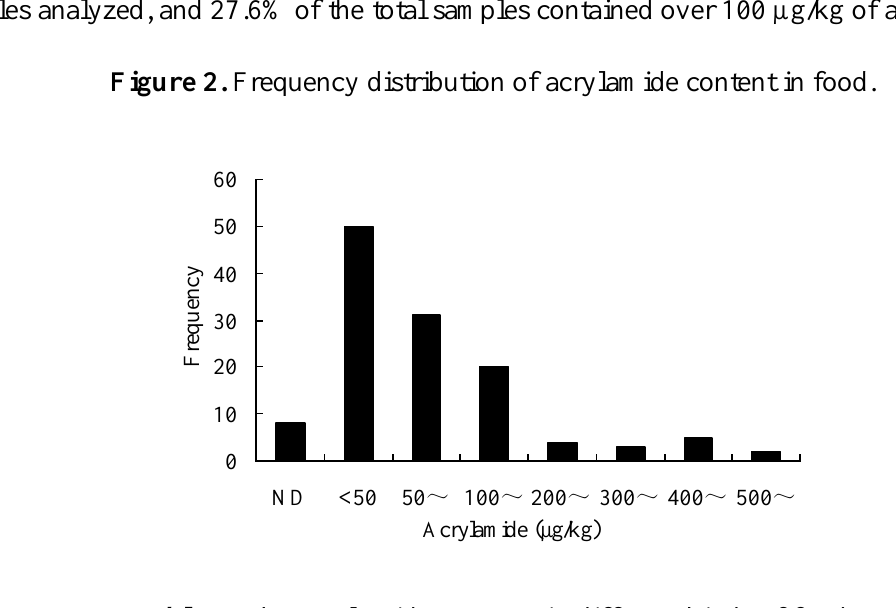
Table 2. The acrylamide contents in different kinds of